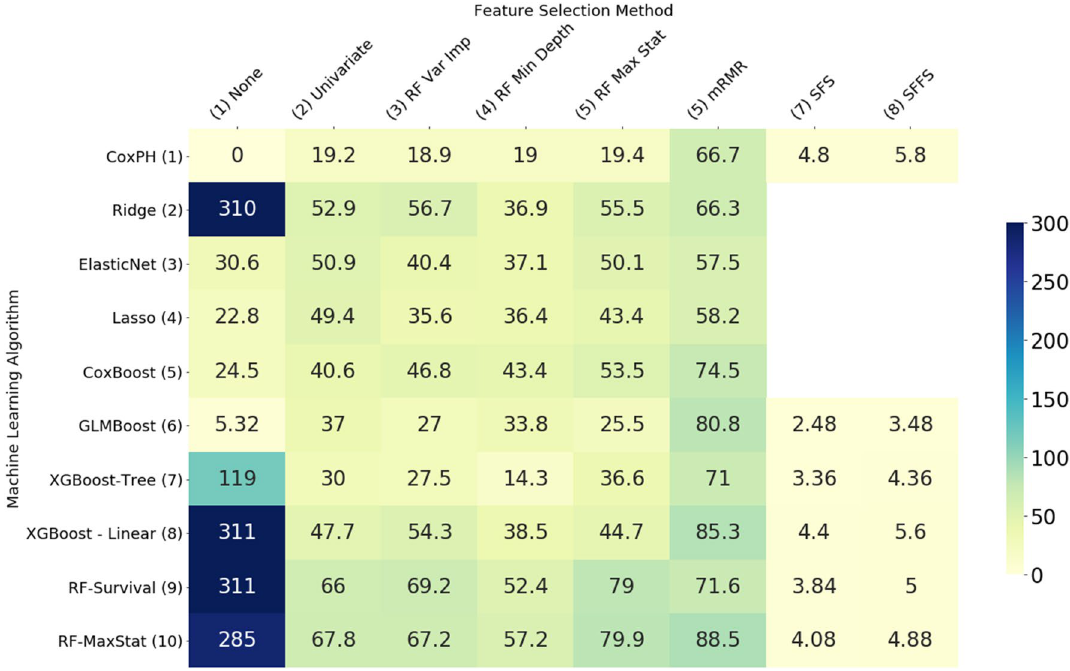
Figure 3. Average number of features selected by each model—MAS dataset.